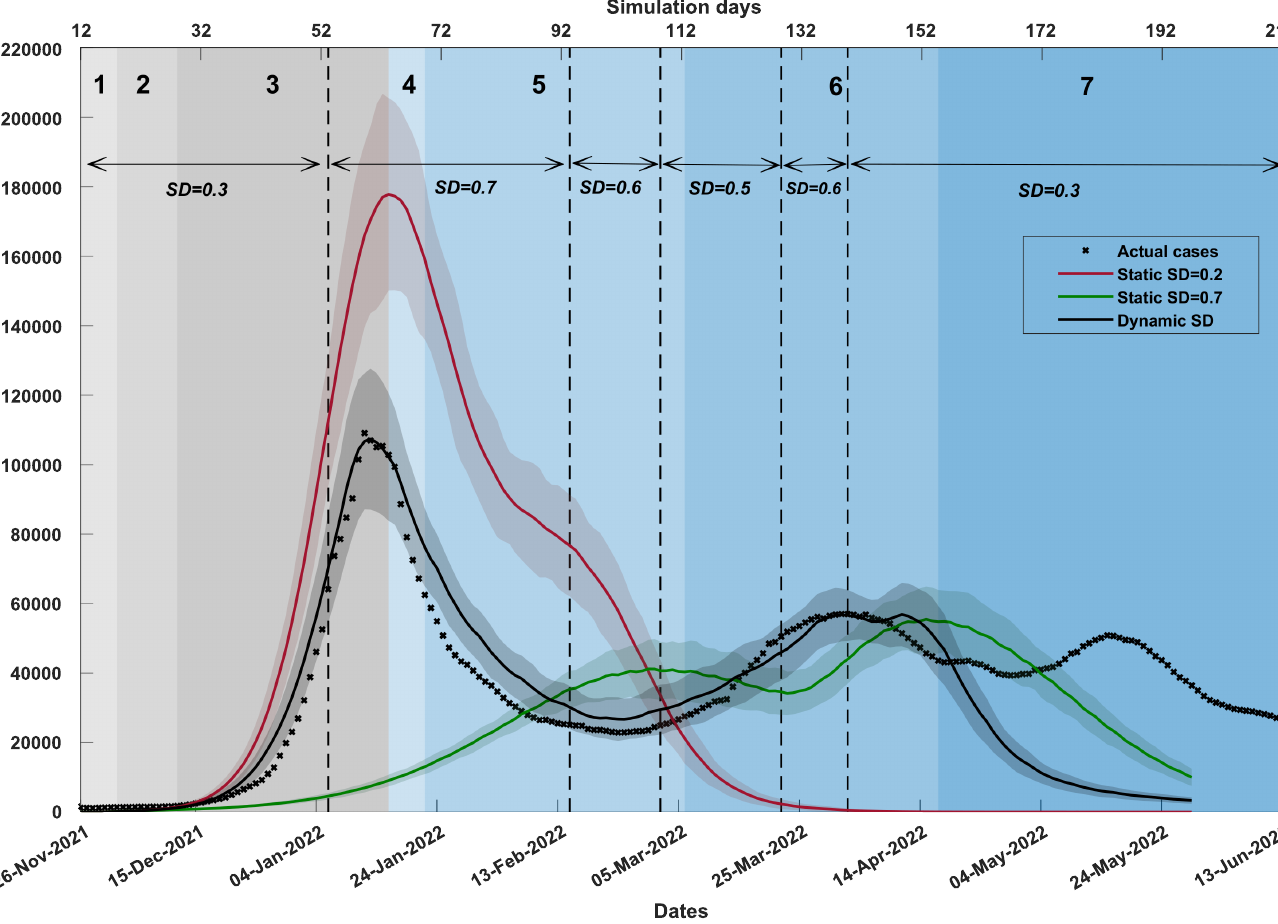
Fig 2. A comparison of incidence produced by different social distancing (SD) profiles. The plot contrasts dynamic social distancing (SD) adoption (shown in solid black) and static SD-adoption fractions ( SD 1 = 0.2, shown in red; SD 2 = 0.7, shown in green). Coloured shaded areas around the solid line show standard deviation. Changes in dynamic SD-adoption are marked by vertical dashed black lines. Traces corresponding to each simulated scenario are computed as the average over 20 runs. Simulated SD adoption is combined with other interventions (i.e., school closures, case isolation, and home quarantine). A 7-day moving average of the actual time series (black crosses) is shown for the period between 26th November 2021 and 13th June 2022 (x-axis, bottom). The simulated incidence is scaled up by 10% to reflect the population increase from 23.4 million (2016 census data, model input) to 25.8 million (2021 census data). The simulated incidence is offset by 12 days (x- axis, top) to align with the observed incidence peak. Shaded areas in grey and blue show the emergence of variants of concern and sub-lineages over time, identified in weekly genomic surveillance reports (NSW Health).